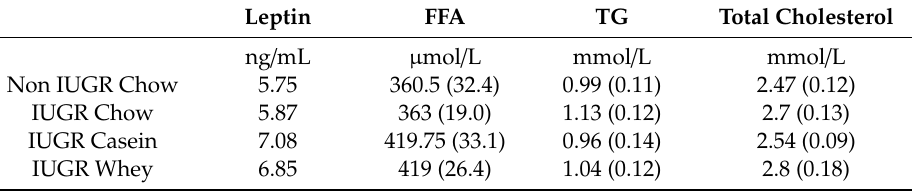
Values are median (SE median); n = 18–20 /